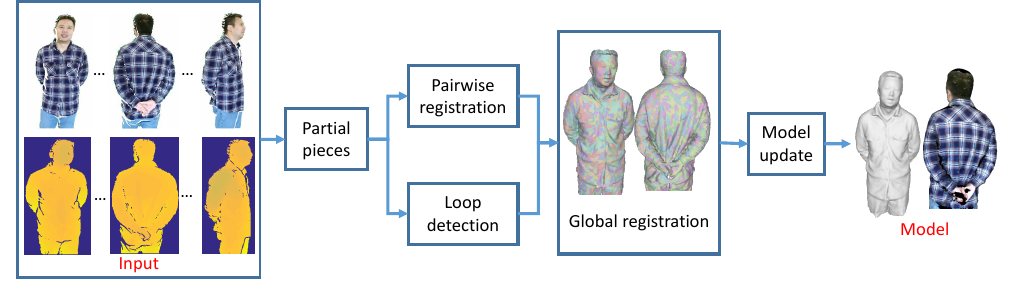
Figure 2. The pipeline of our method.